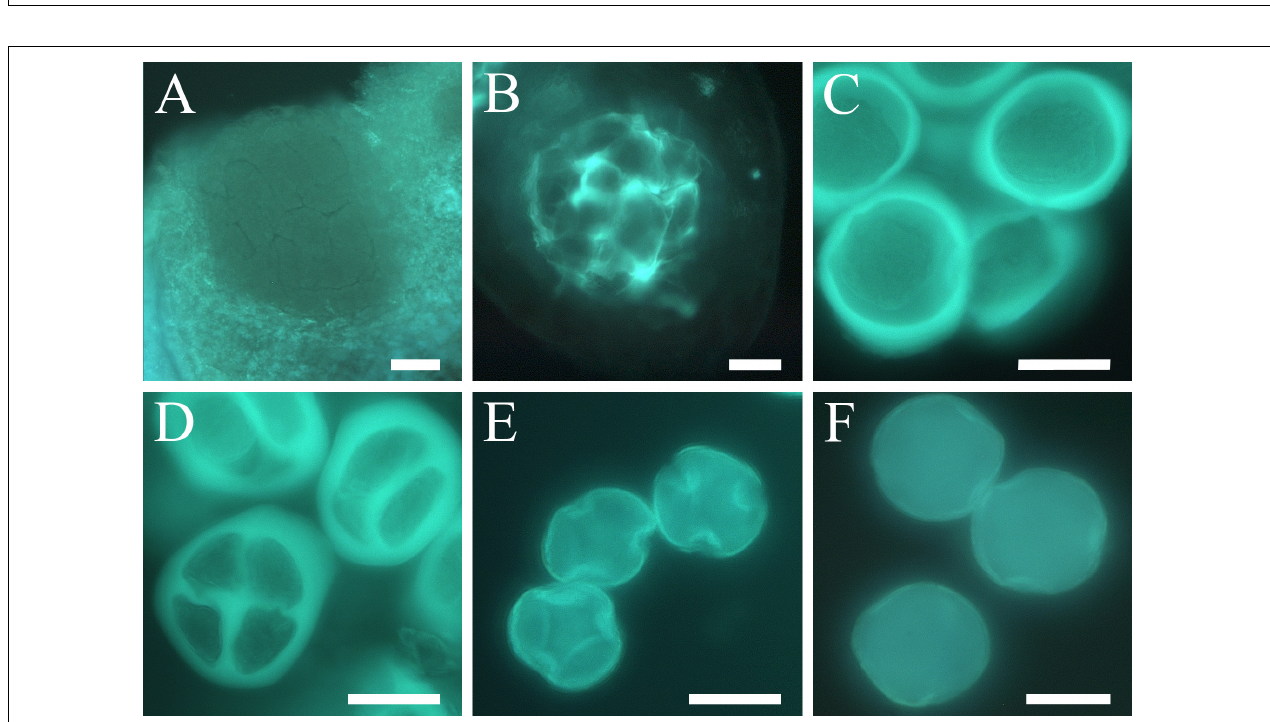
FIGURE 4 | Model coefficients of a partial least squares regression model of daily accumulation of winter chill [ (A) quantified in Chill Portions] and heat [ (B) quantified in growing degree hours] and bloom dates of the apricot cultivar “Pandora.” Top panels show the variable importance in the projection (VIP), with the blue bars values above 0.8 indicating the threshold for variable importance. Middle panels show the model coefficients of the centered and scaled data. The chilling period is colored in blue and the heating period is colored in red. The bottom panels show mean temperatures (black line) and their standard deviation (gray areas). In the middle and bottom panels, red and green scales show negative and positive coefficients, respectively.